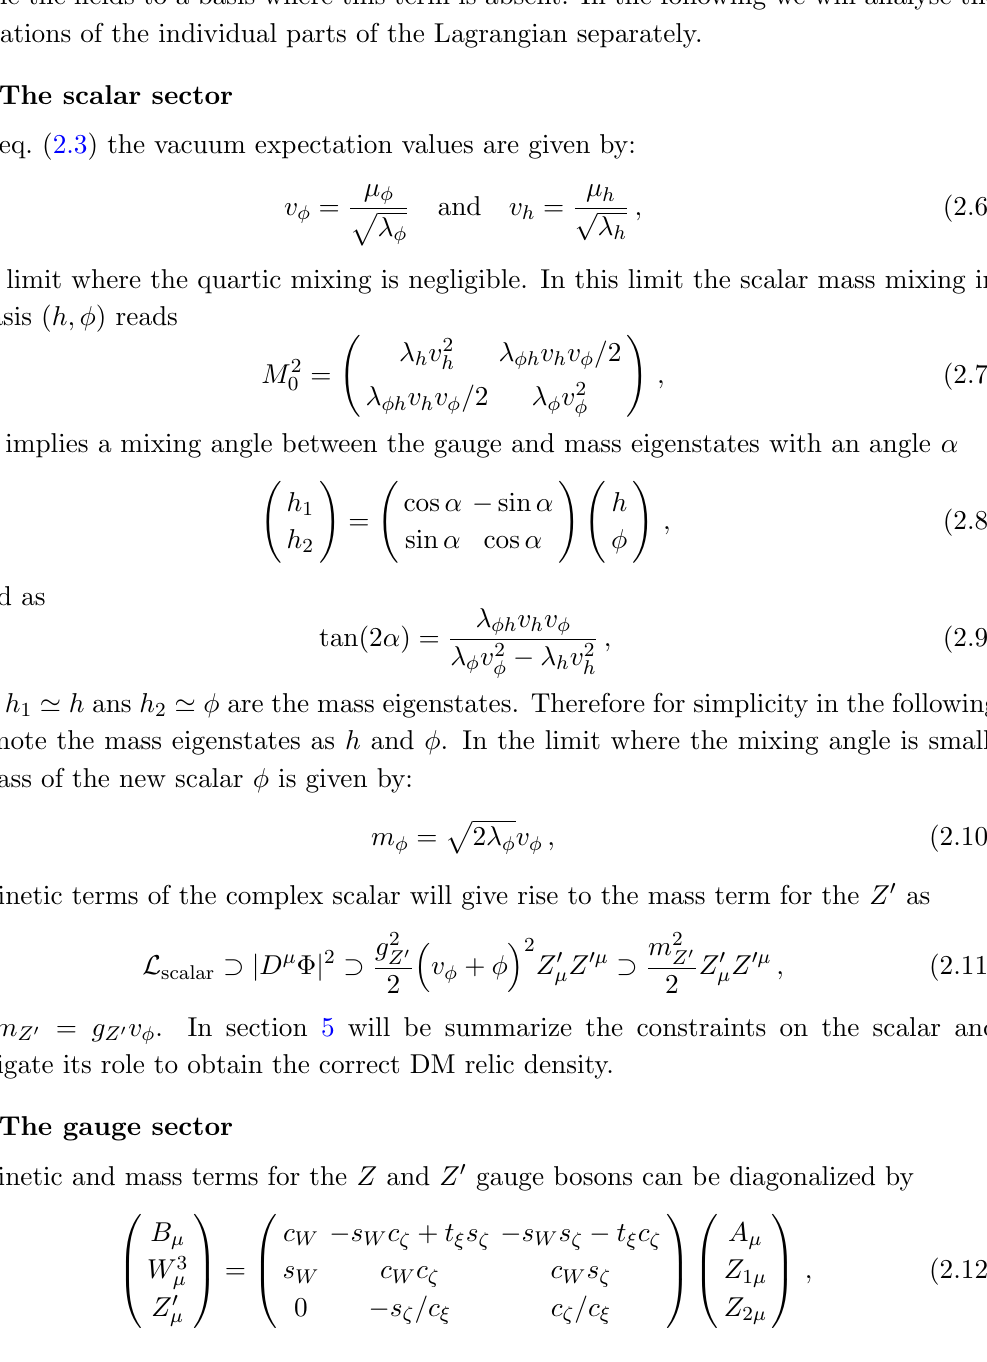
should remain small at N ! could be included but one can always R L